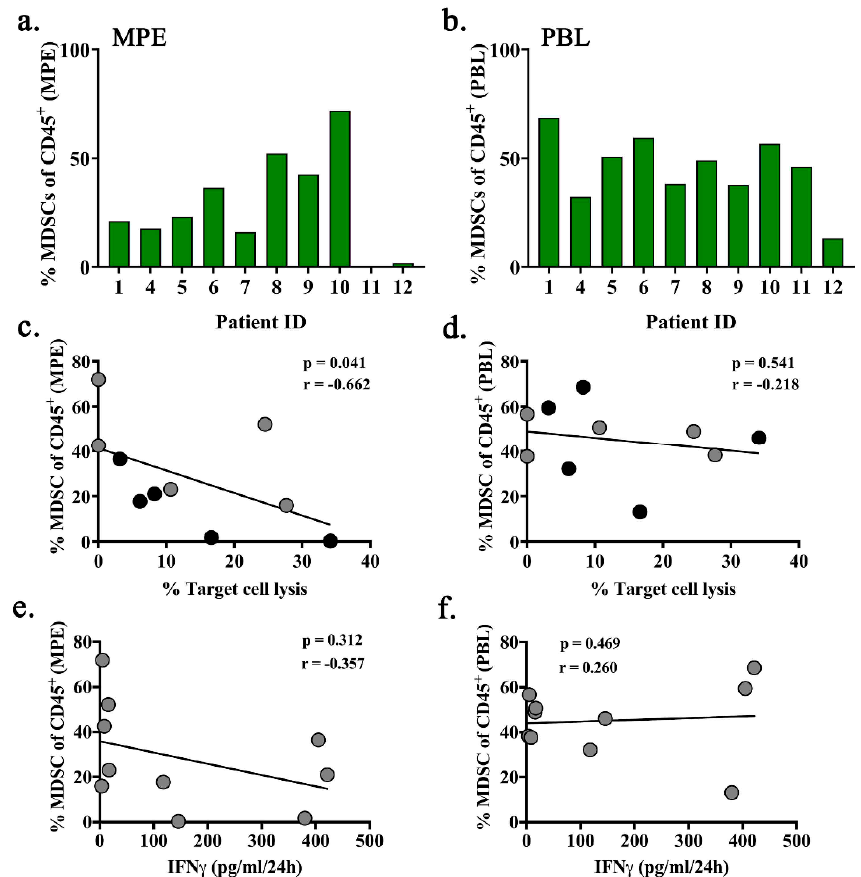
Figure 5. Intrapleural MDSCs are associated with reduced cytolytic capacity of MPE-resident CD8 + T cell. MDSCs were identified in MPE and PBL by flow cytometry as CD45 + SSC High HLA-DR Low CD14 + and / or CD15 + including both polymorphonuclear and monocytic subtypes. The proportion of MDSC shown as the percentage of total CD45 + leukocytes per patient are depicted for ( a ) MPE and ( b ) PBL. Spearman correlations between the percent of MDSCs in ( c ) MPE or ( d ) PBL and patient MPE-resident CD8 + T cell cytotoxicity upon co-culture with autologous non-hematopoietic MPE cells (highest value from co-cultures with either IL-2 alone [gray dots] or IL-2+anti-CD3/CD28 microbeads [black dots]). Spearman correlations between percent MDSCs in ( e ) MPE or ( f ) PBL and patient MPE-resident CD8 + T cell IFN γ production upon co-culture with autologous non-hematopoietic MPE cells.